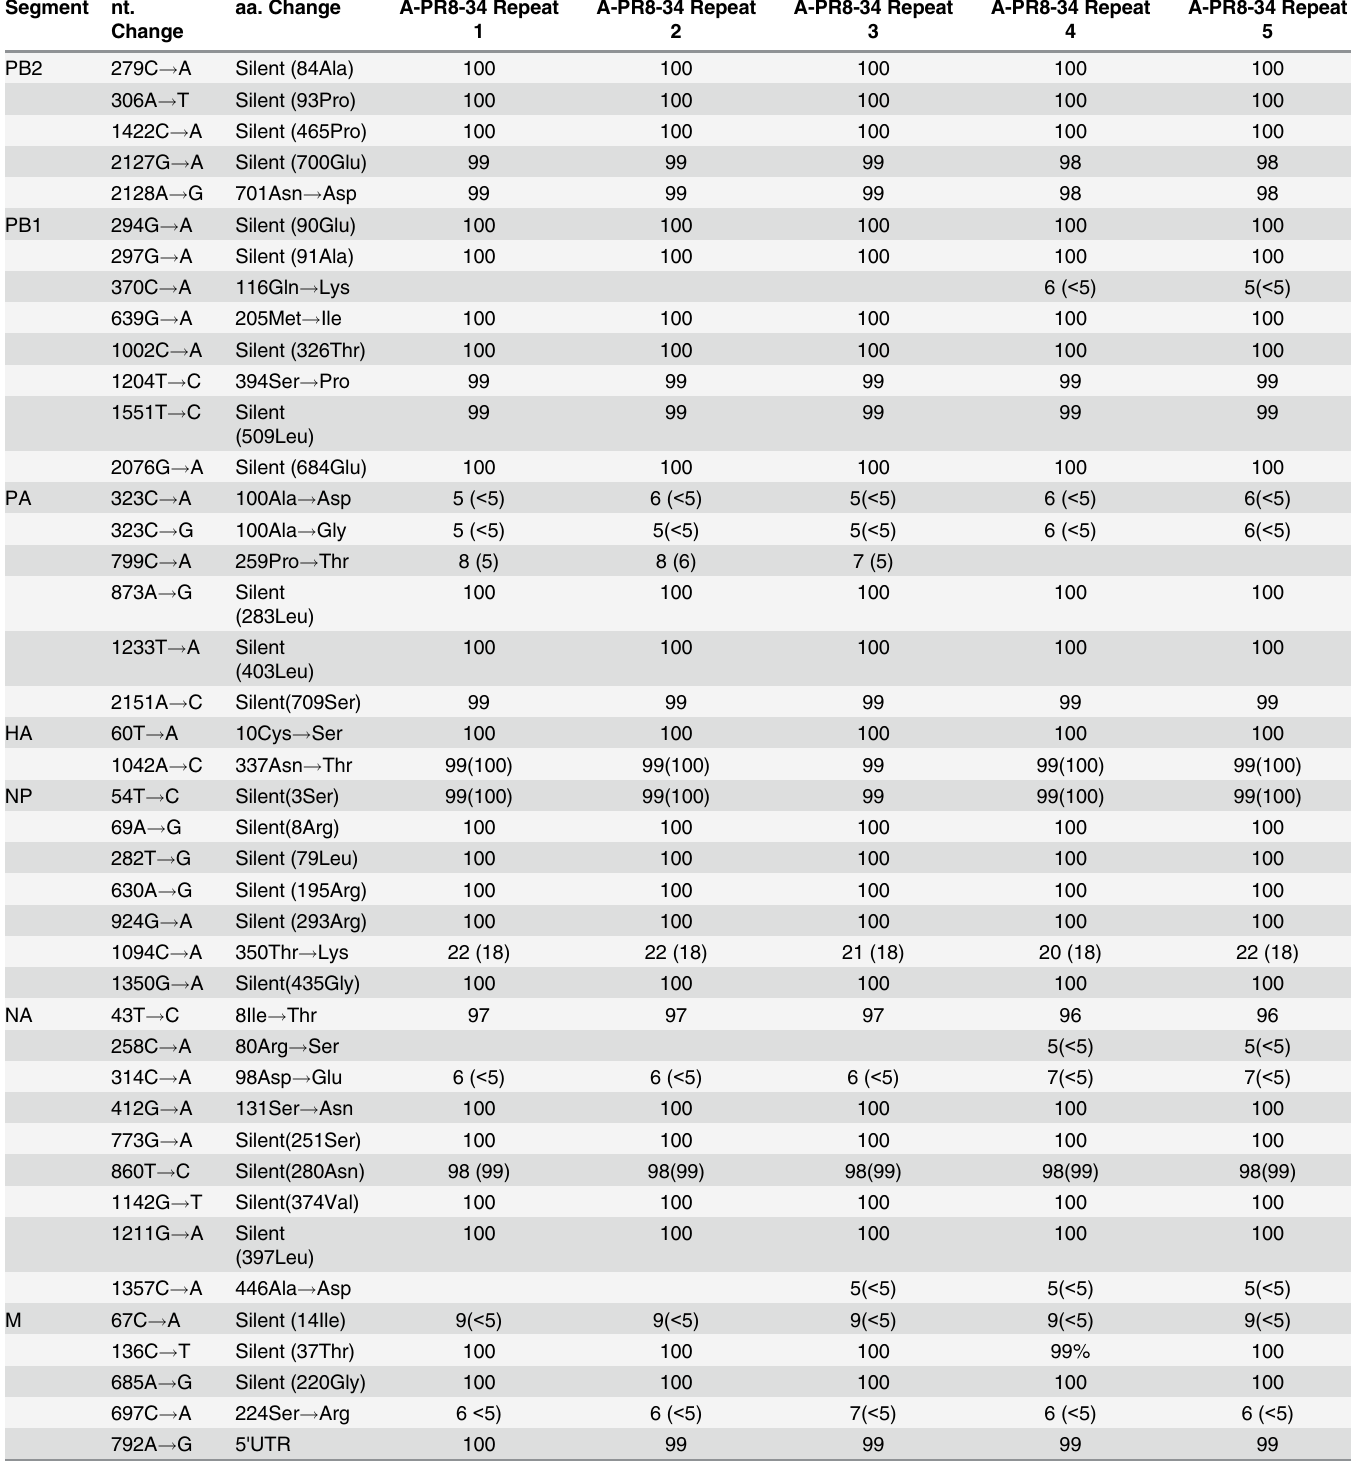
Table 2. Percentage of mutations ( (cid:3) 5%) emerged in the genome of A/PR/8/34 strain (CBER stock) obtained by sequencing five times its RNA library by HiSeq and MiSeq. Notes: MiSeq values that differ from HiSeq's values are presented in parentheses. These mutation percentages were calcu- lated per comparison to their published sequences. (See accession numbers in Materials and Methods paragraph.) nt: Nucleotide, aa: Amino-acid. Segment nt.